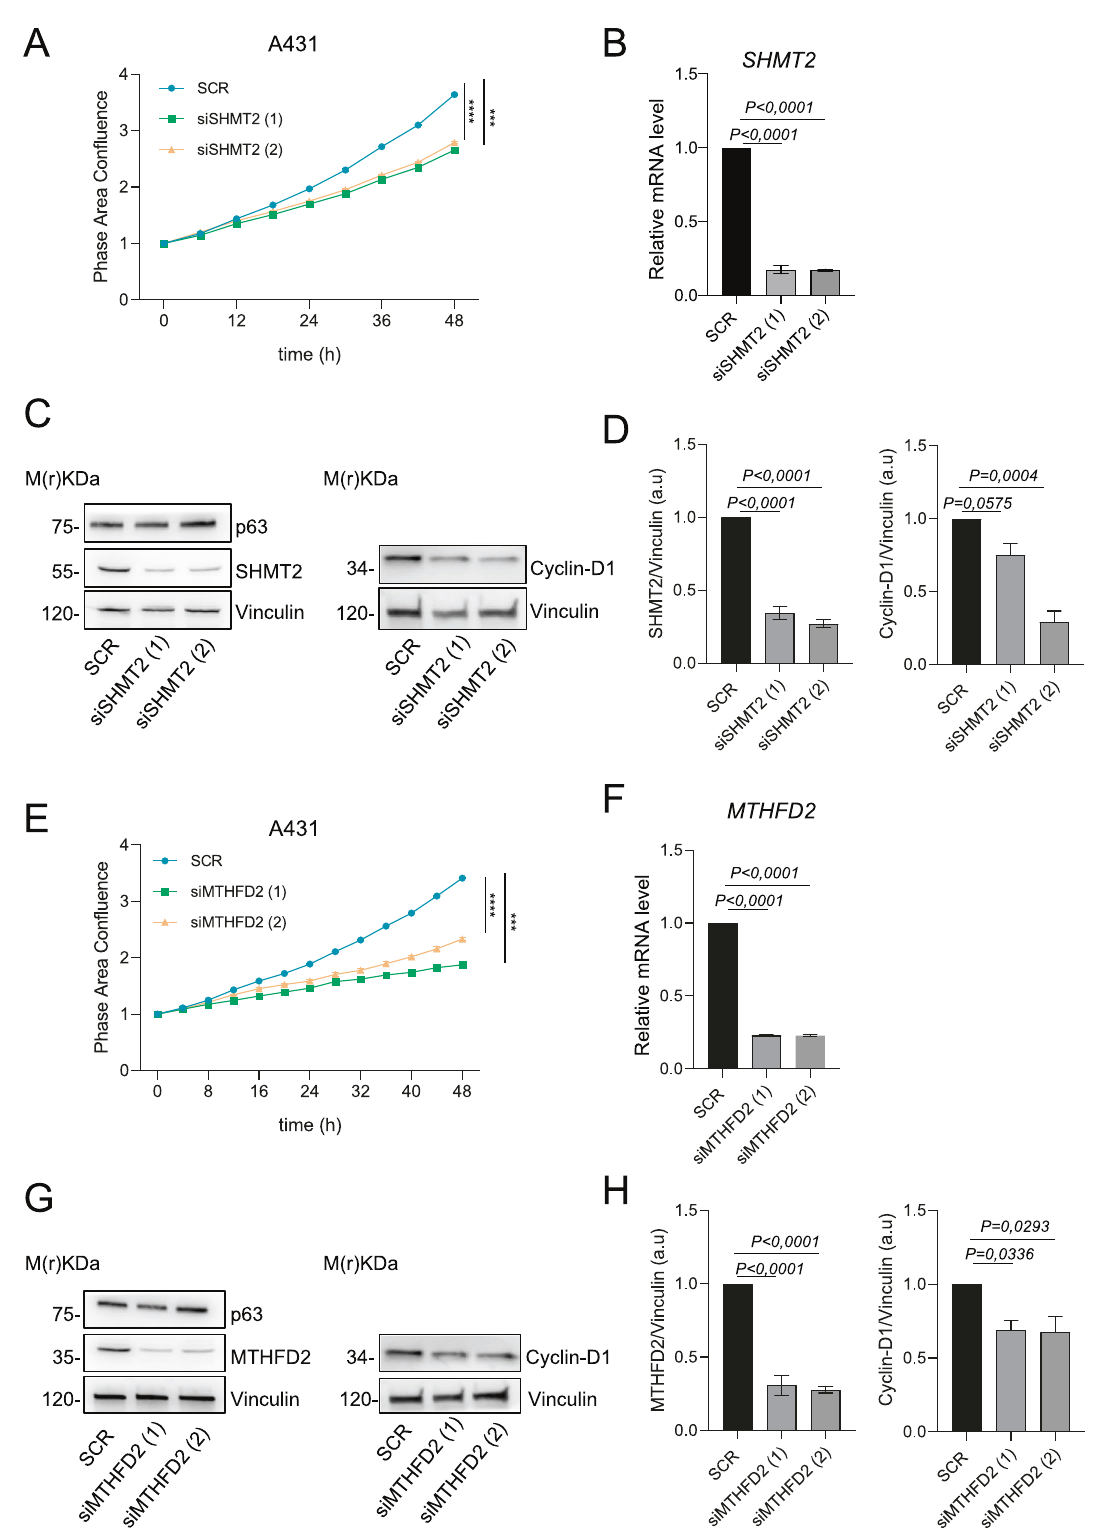
Fig. 3 SHMT2 and MTHFD2 silencing effects on A431 proliferation. A Con fl uence analysis of A431 cells after SHMT2 silencing. B SHMT2 expression analysis through qPCR after silencing. C Western blot analysis after SHMT2 silencing, one representative experiment of 3 is shown. D Relative ratio of SHMT2 and Cyclin-D1 expression normalized to that of Vinculin. E Con fl uence analysis of A431 cells after MTHFD2 silencing. F MTHFD2 expression analysis through qPCR after silencing. G Western blot analysis after MTHFD2 silencing, one representative experiment of 3 is shown in H . Relative ratio of MTHFD2 and Cyclin-D1 expression normalized to that of Vinculin. The p -value was obtained using Student ’ s t test and One-Way Anova. Values were considered signi fi cant when the p -value < 0.05, n.s. not signi fi cant.